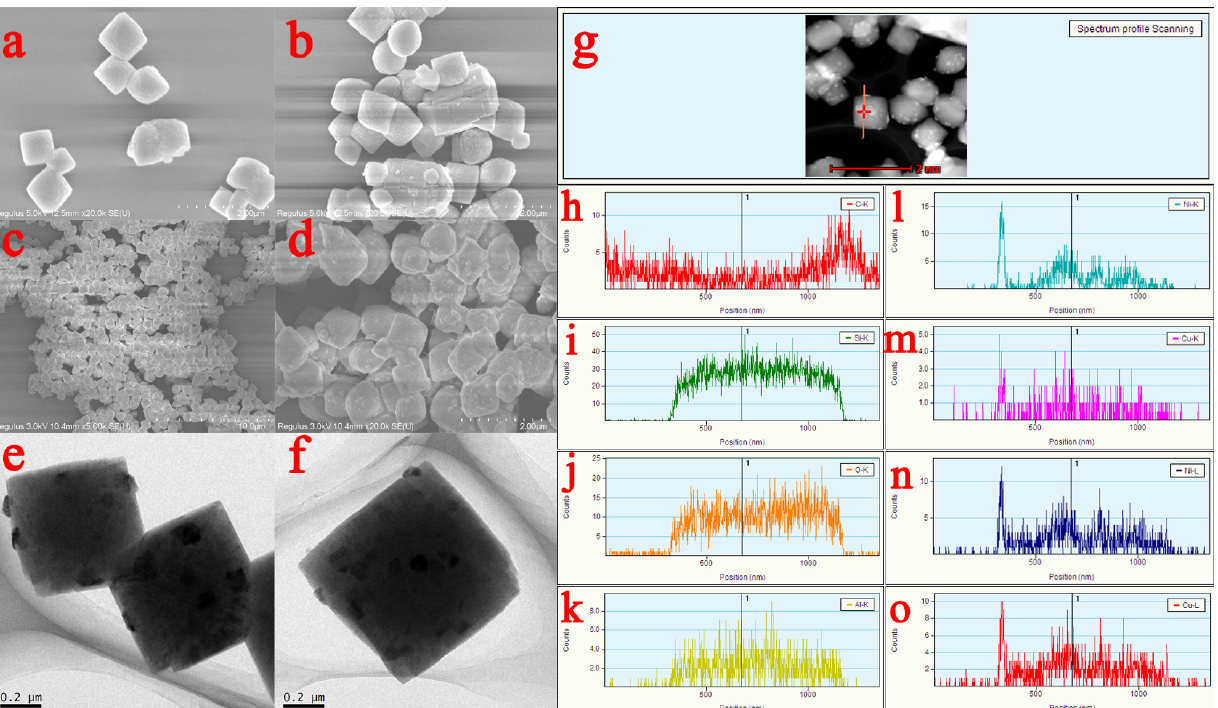
Figure 2. ( a , b ) The SEM results of Ni 7 Cu/ZSM-12; ( c , d ) SEM results of Ni 7 Cu/ZSM-12 after stability test; ( e , f ) the TEM results of Ni 7 Cu/ZSM-12; ( g – o ) EDS line profile results of Ni 7 Cu/ZSM-12.